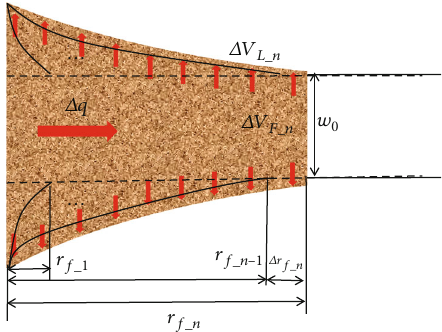
Figure 3: Schematic diagram of the increment of drilling mud loss in a naturally fractured formation within Δ